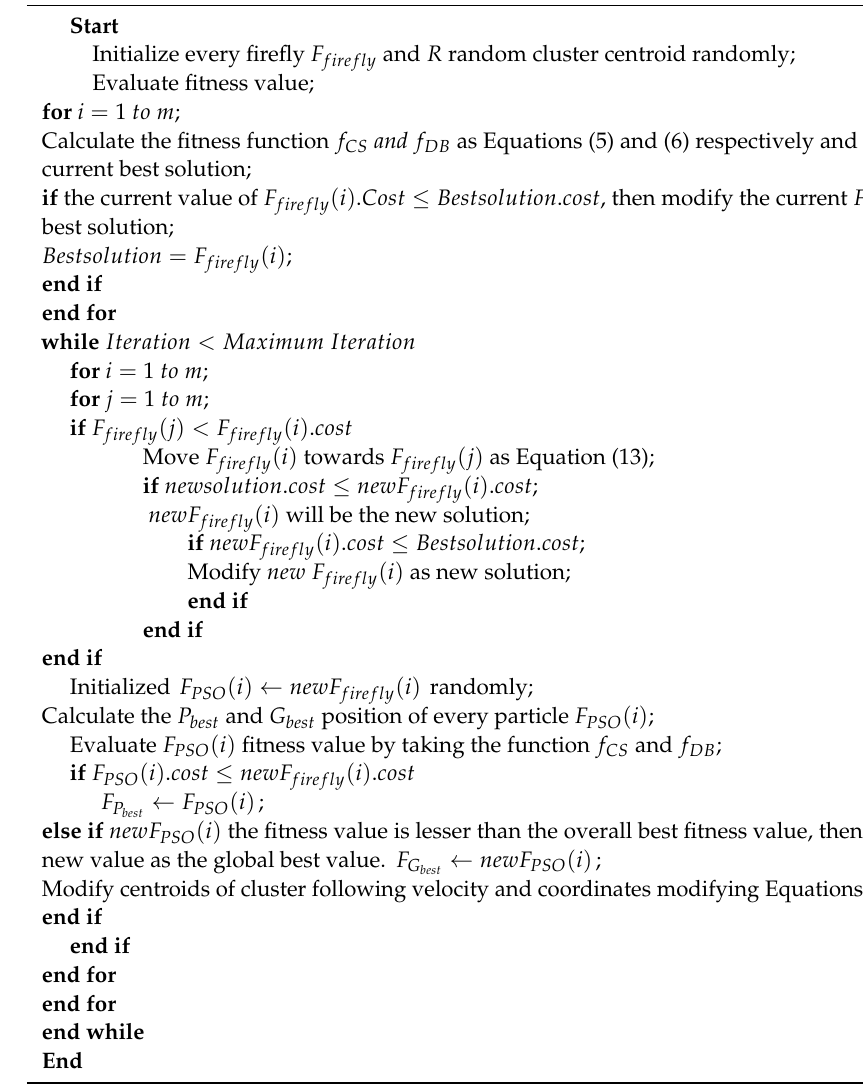
Algorithm 2. Pseudo code for